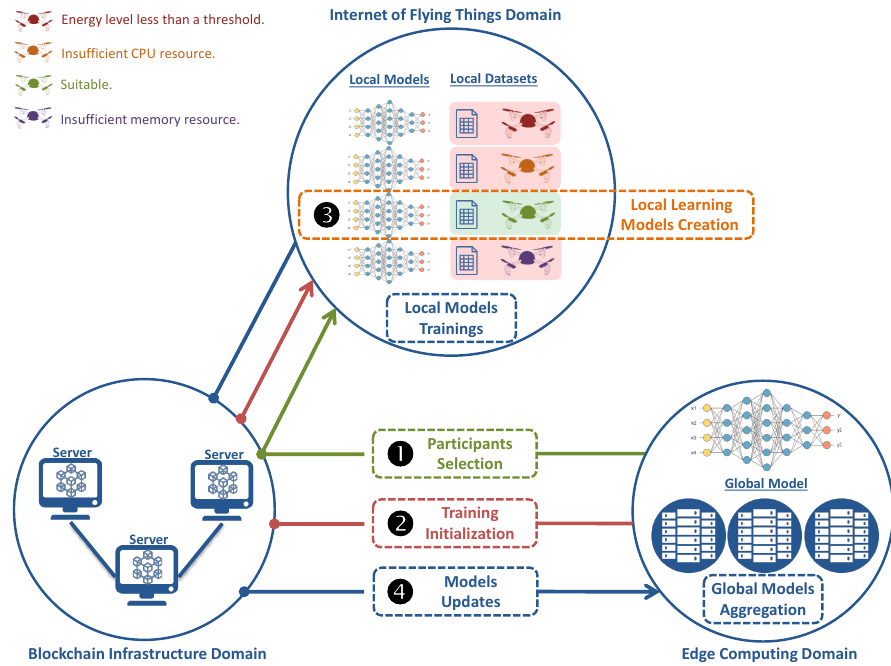
Figure 3. Overview of UAV Selection Problems in Edge-enabled Secure